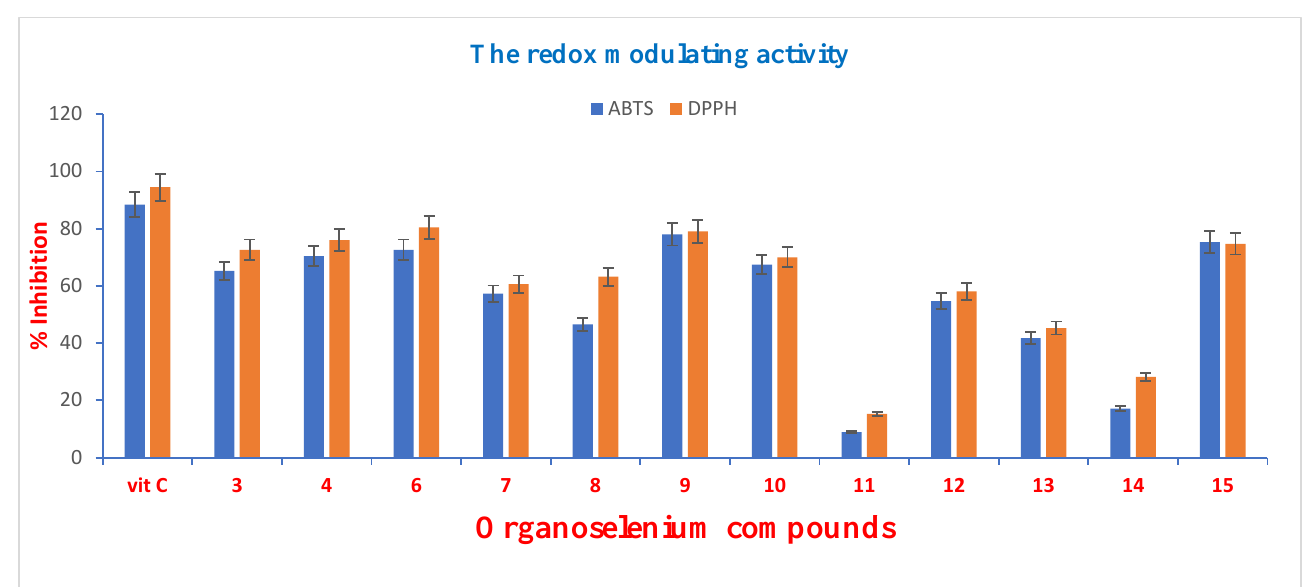
Figure 2. The OSe compounds redox activities assessment using the ABTS and DPPH experiments. All tests are mean ± SD. ABTS experiment: absorbance was followed at 734 nm for OSe compounds (50 µL, 1 mM in MeOH) and ABTS solution (60 µL). DPPH experiment: Absorbance was monitored